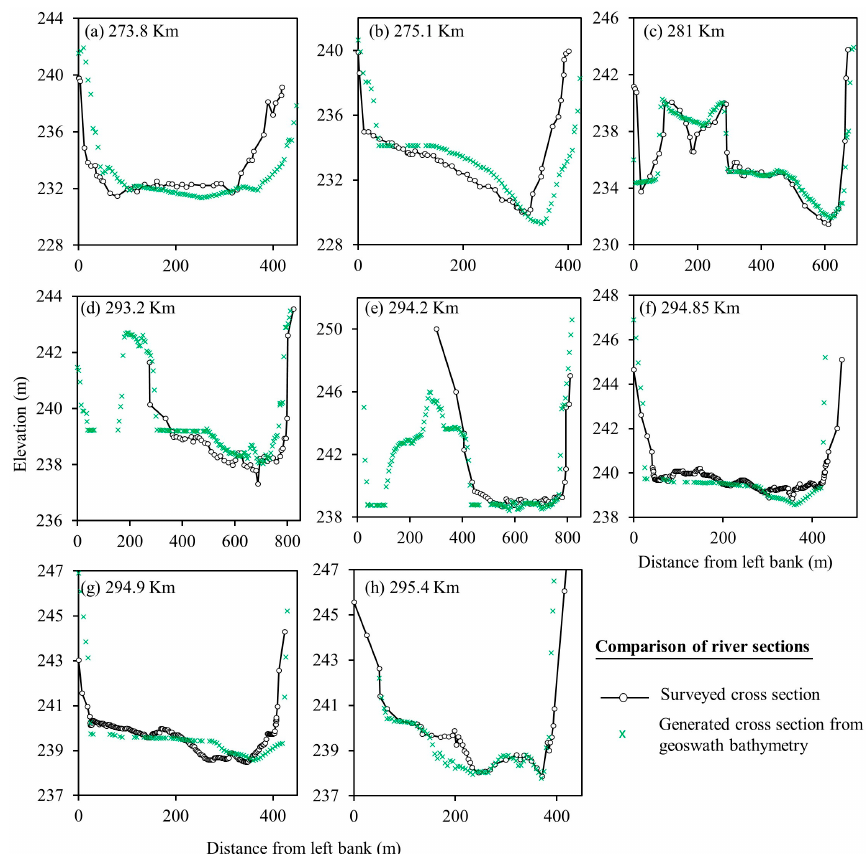
Figure 8. Comparison of the predicted surface with surveyed cross sections.